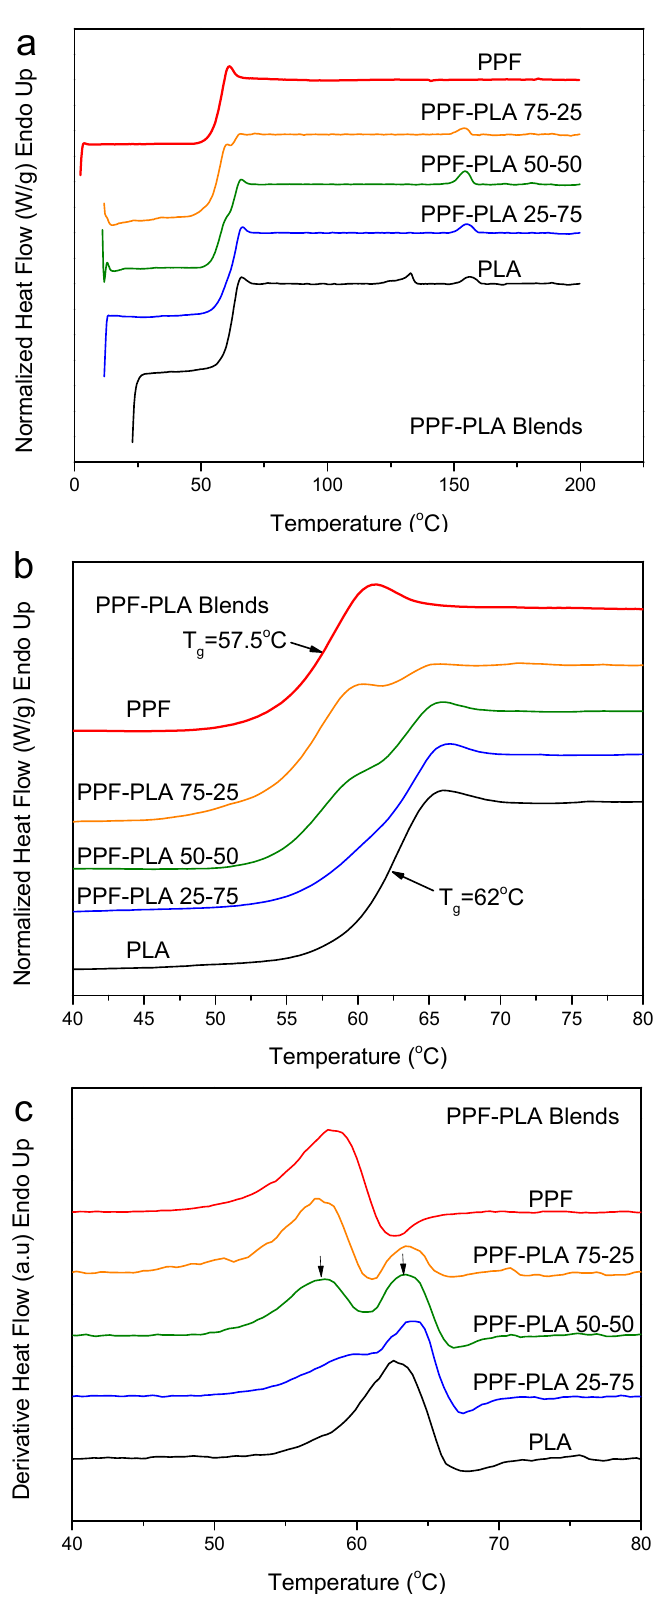
Figure 11. ( a ) DSC heating thermograms, ( b ) details of DSC thermograms in the T g region and ( c ) derivative heat flow for melt-quenched PLA–PPF blend samples.